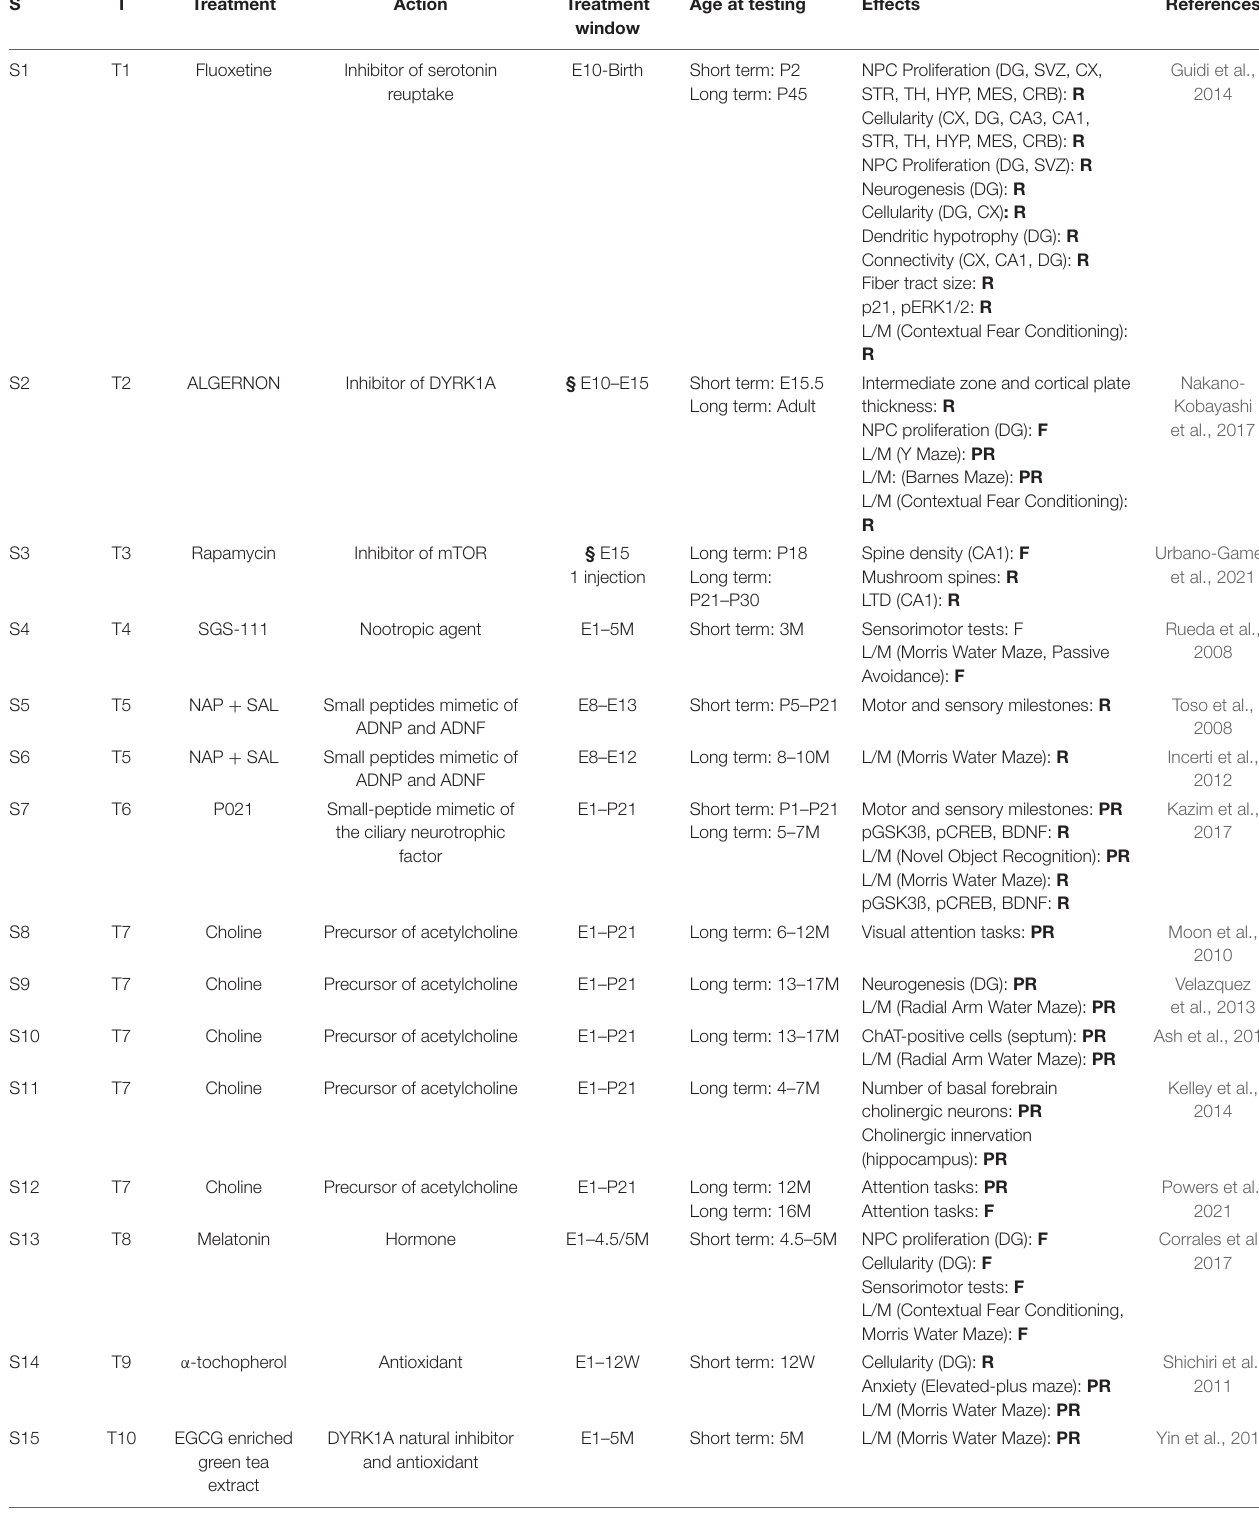
TABLE 1 | Treatments administered at embryonic life stages in DS mouse